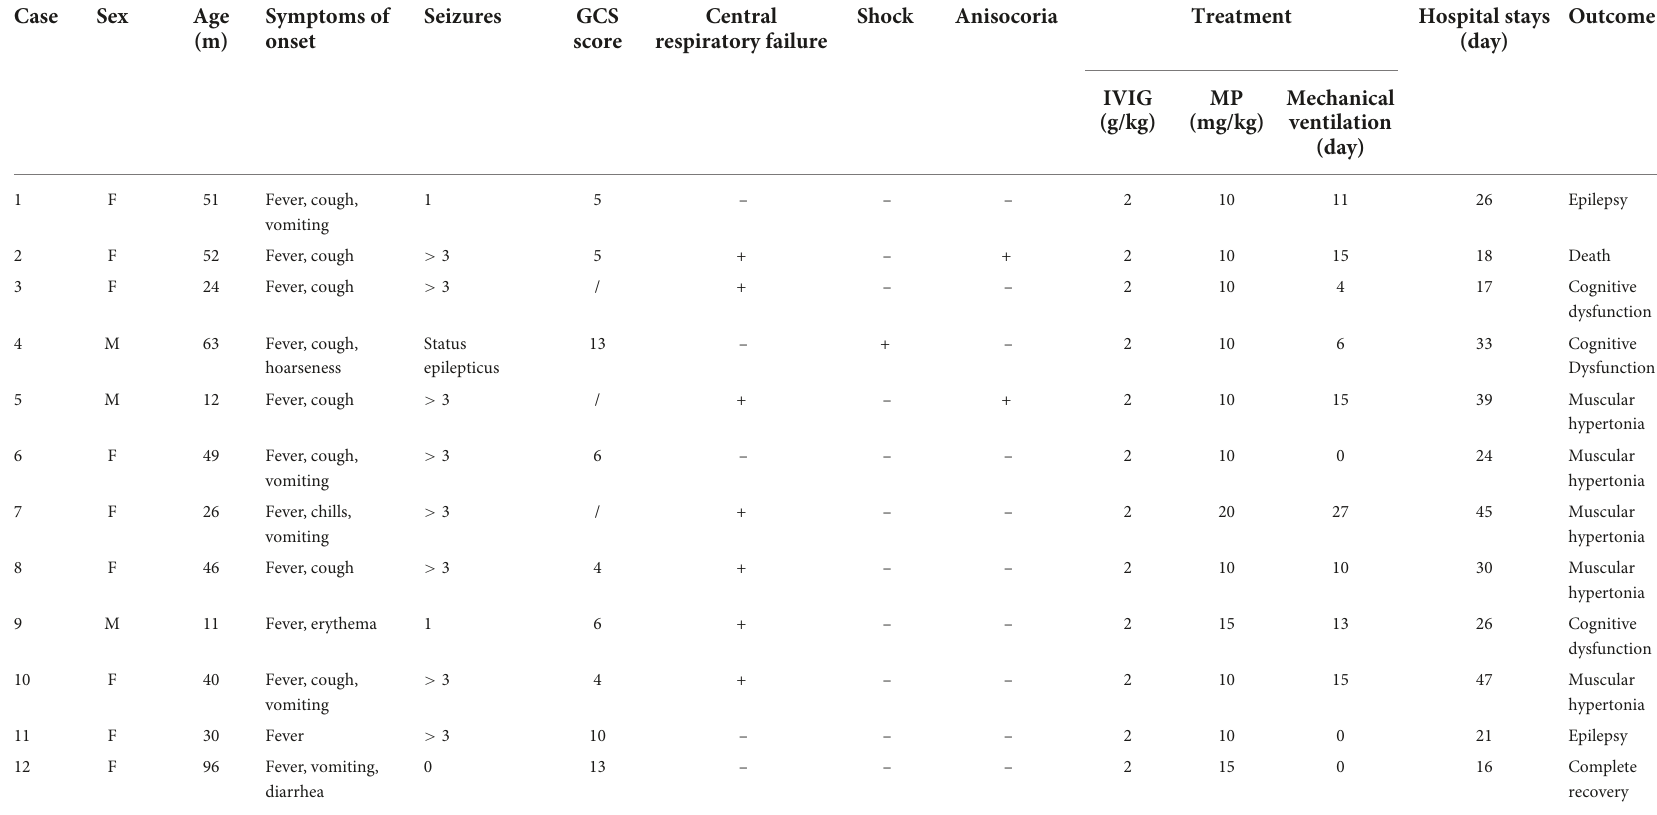
TABLE 1 Patient